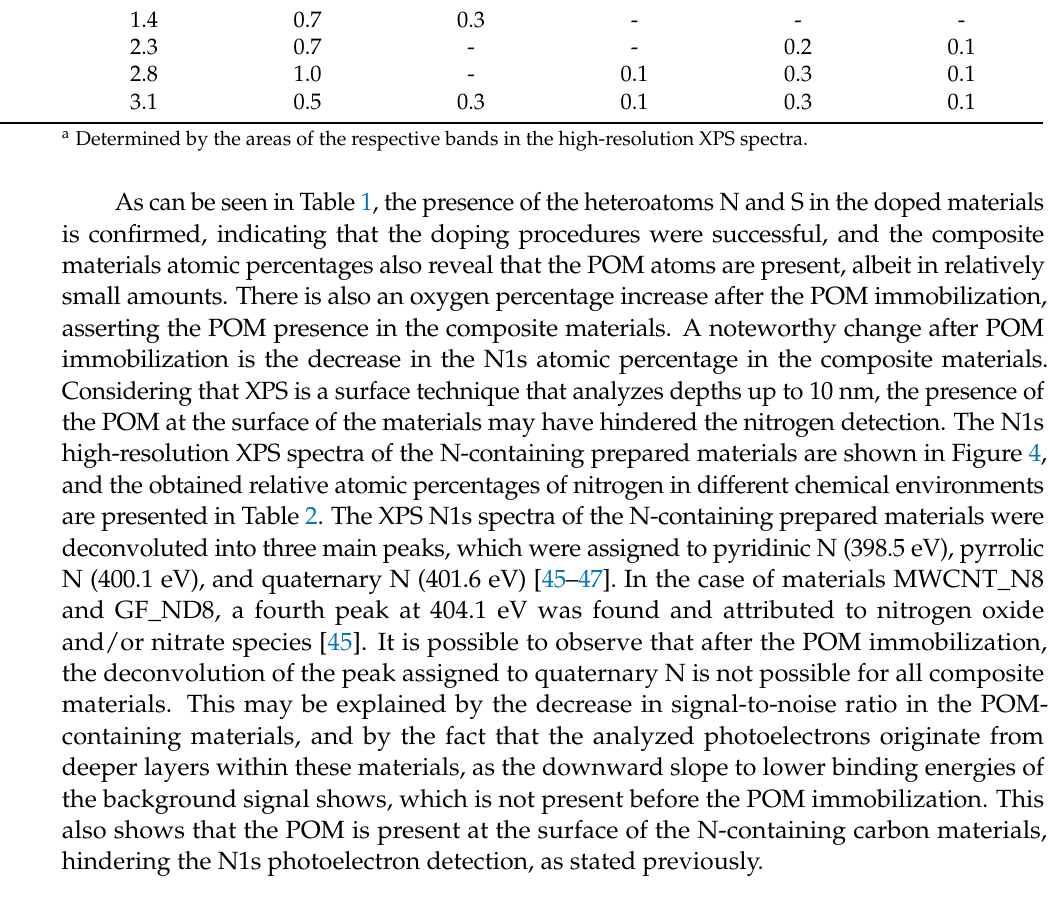
Table 2. Relative atomic percentages of nitrogen presented in the XPS high-resolution N1s spectra